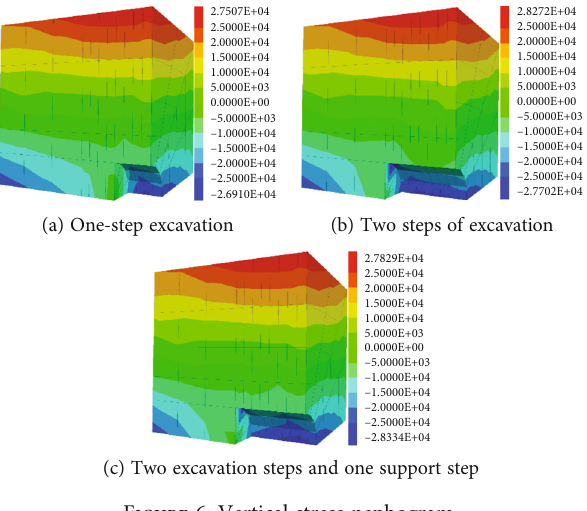
Figure 6: Vertical stress nephogram.